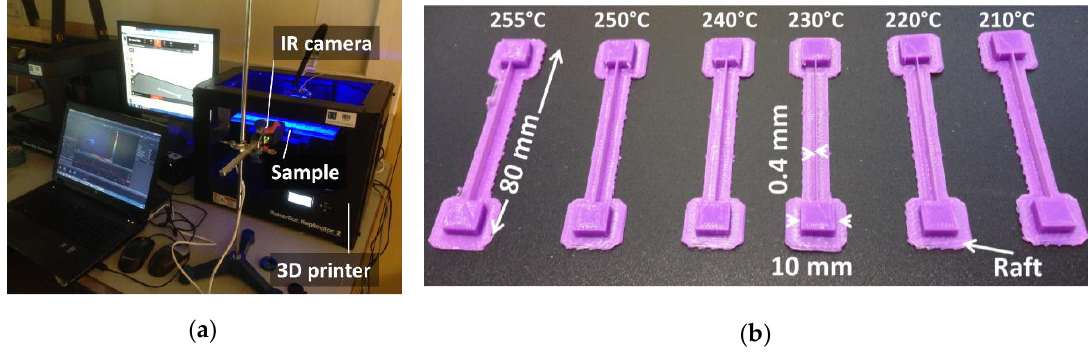
Figure 2. Infra-red measurements: ( a ) Setup; ( b ) produced samples for all printing temperatures.